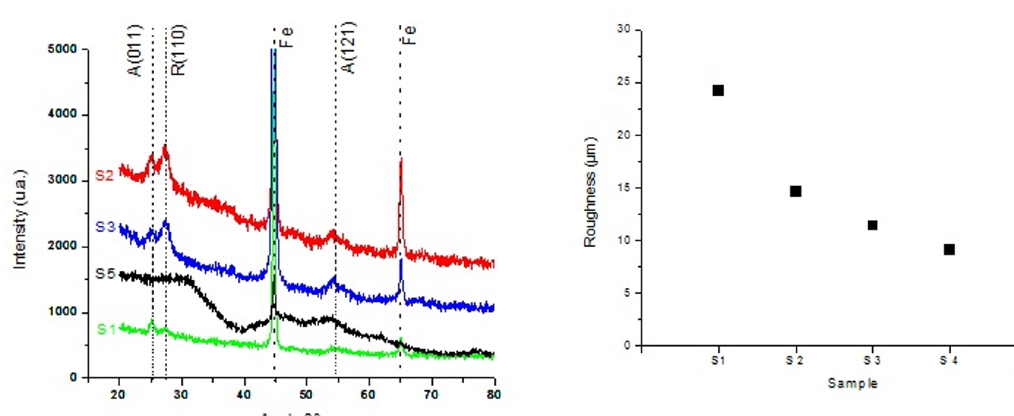
Figure 4. Mean roughness values for TiO